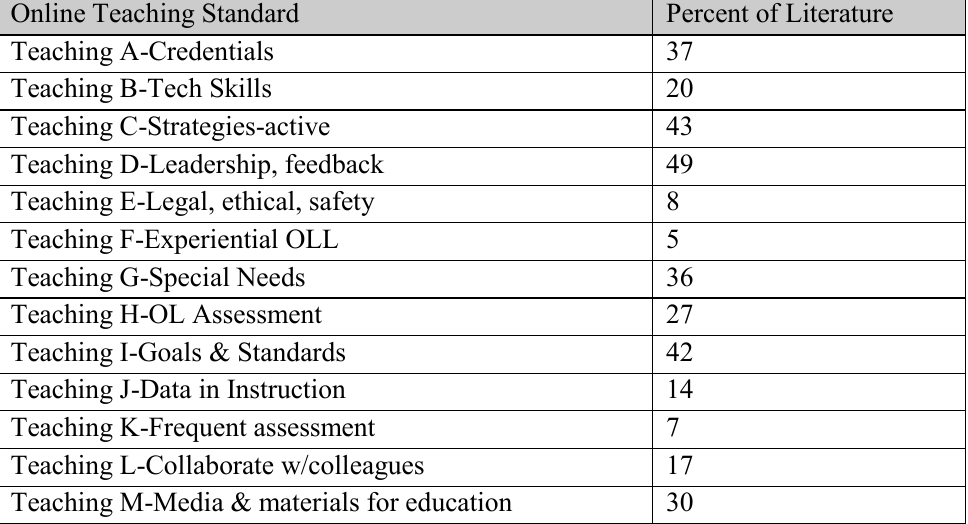
Percentage of Literature about Online Teaching Standards Online Teaching